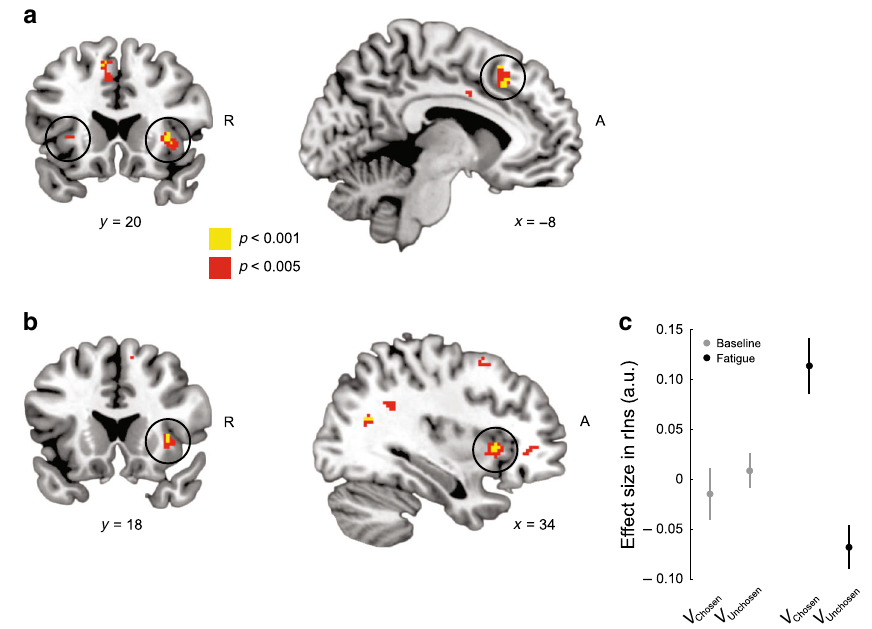
Fig. 3 Neural signatures of chosen effort value ( n = 20). a Overall effort value encoding. Whole brain results thresholded at voxelwise p < 0.005 (red) and p < 0.001 (yellow). Activity in bilateral insula (rIns: peak = [34, 20, 2]; lIns: peak = [ − 32, 24, 2]; small volume corrected p < 0.05 in a priori ROI) re fl ects the difference in chosen and unchosen effort value at the time of choice, across both the baseline and fatigue choice phases. Activity was also observed in ACC (MNI coordinate: peak = [ − 8, 24, 42]), although it does not survive small volume correction in our a priori ACC ROI. b Effort value encoding in rIns increases with fatigue. Activity in rIns (peak = [34, 18, 2]; small volume corrected p < 0.05 in a priori ROI) re fl ects the difference of chosen and unchosen effort value between the baseline and fatigue choice phases. c Effects in rIns (5 mm sphere centered at [34, 18, 2]) for chosen and unchosen effort value in the baseline and fatigue choice phases are shown. This plot was not used for statistical inference (which was performed in the SPM framework) and is shown solely to illustrate the pattern of the BOLD signal. Error bars indicate